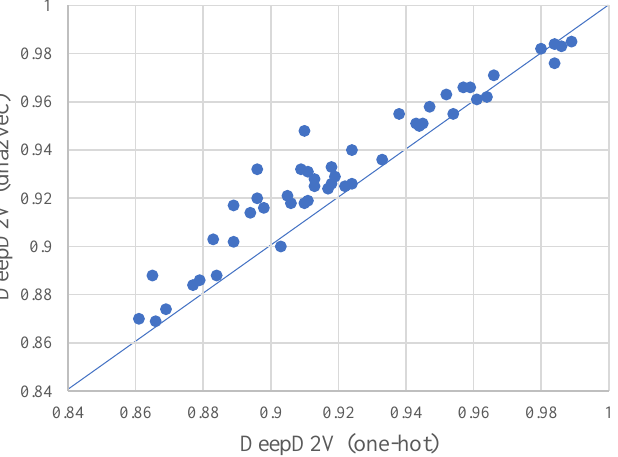
Figure 5. A comparison of DeepD2V uses one-hot encoding and DeepD2V use dna2vec on 50 public ChIP-seq datasets under the ROC AUC